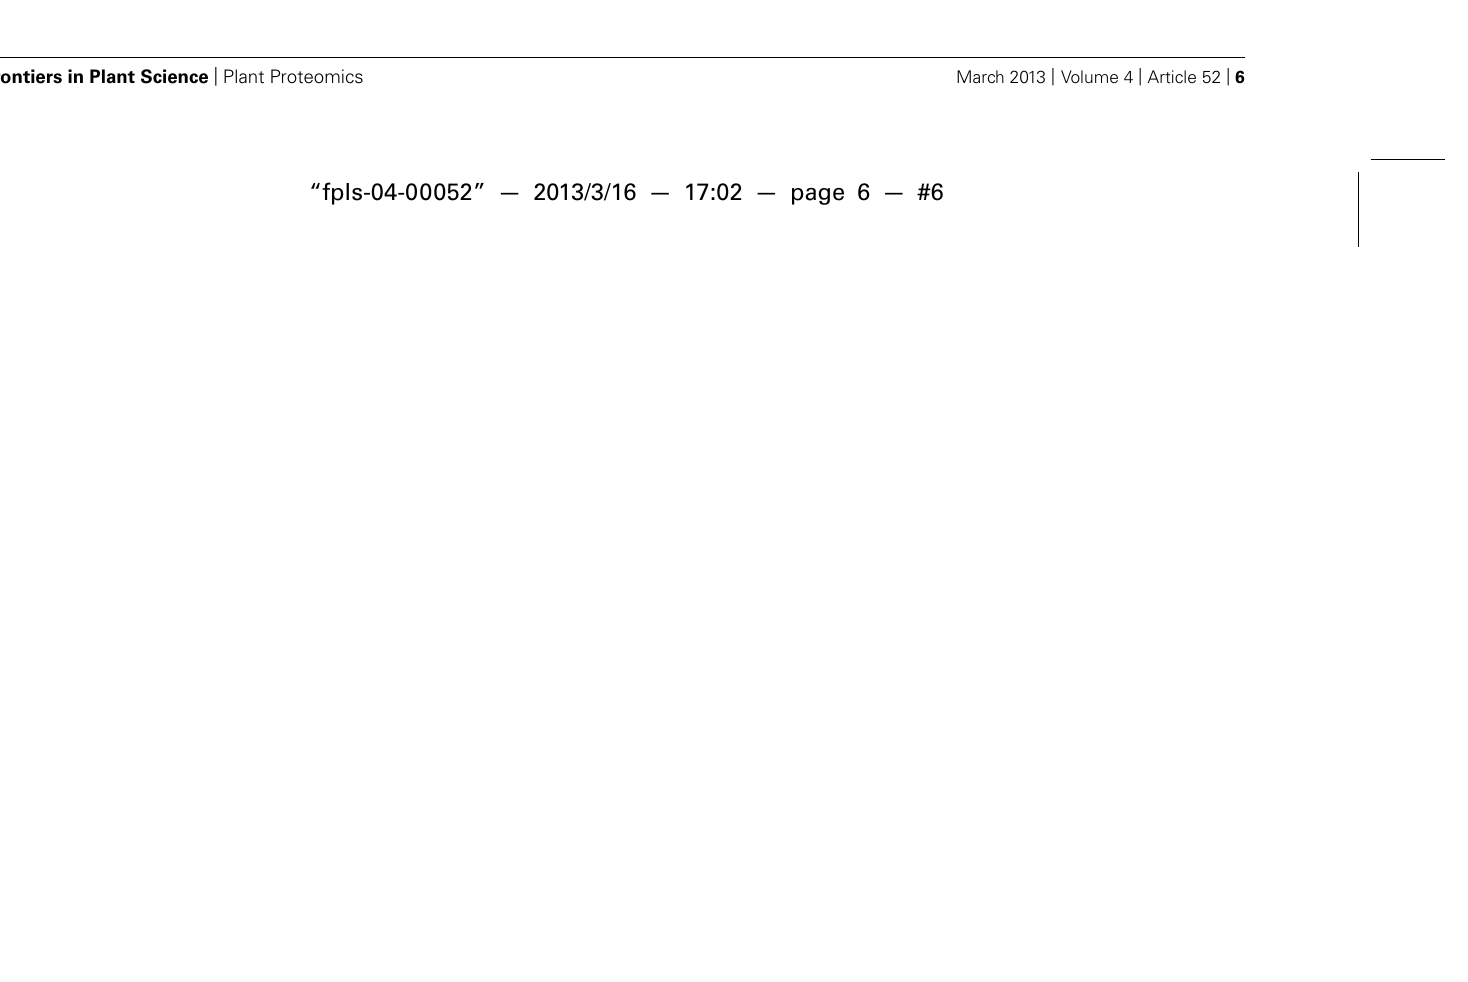
Frontiers in Plant Science | Plant